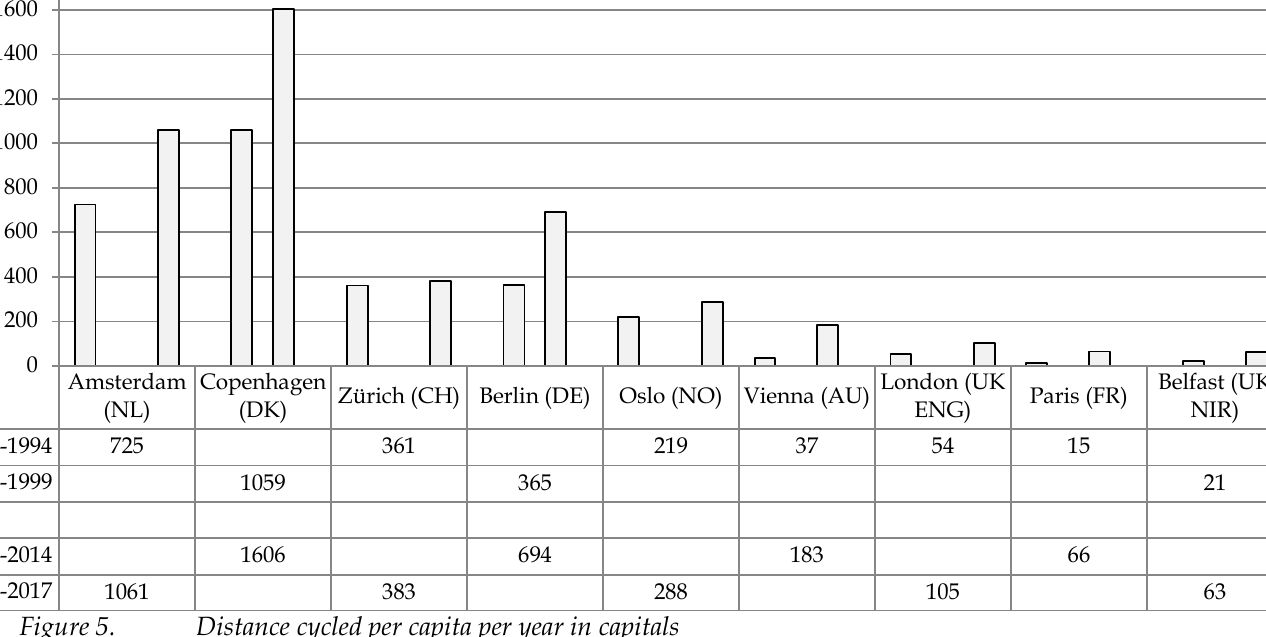
Figure 5. Distance cycled per capita per year in capitals